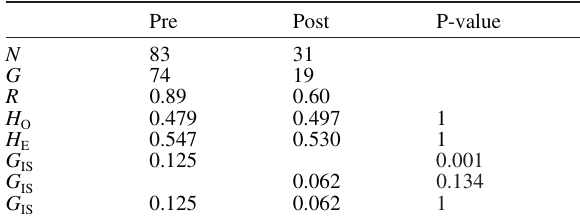
Table 1. – Comparing two Z. marina samples from before (Pre) and after (Post) disturbance. Number of ramets ( N ), number of genets ( G ), genotypic diversity ( R ), observed heterozygosity ( H pected heterozygosity ( H ), inbreeding coefficient ( G E calculated by permutation